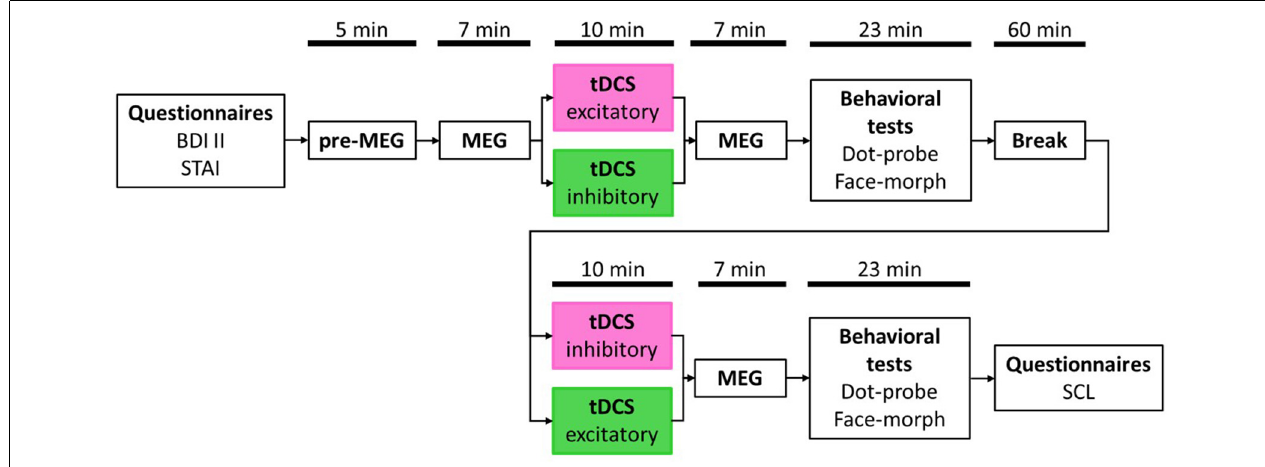
FIGURE 1 | Study timetable. Order of stimulation was balanced with half the participants receiving excitatory transcranial direct current stimulation (tDCS) first and inhibitory tDCS second (pink box) and vice versa for the other half (green box). Magnetoencephalography (MEG) and behavioral test durations are presented as average values, respectively, due to jittered inter-trial intervals (ITIs) in the passive viewing task (MEG) and individual differences in the behavioral tasks.